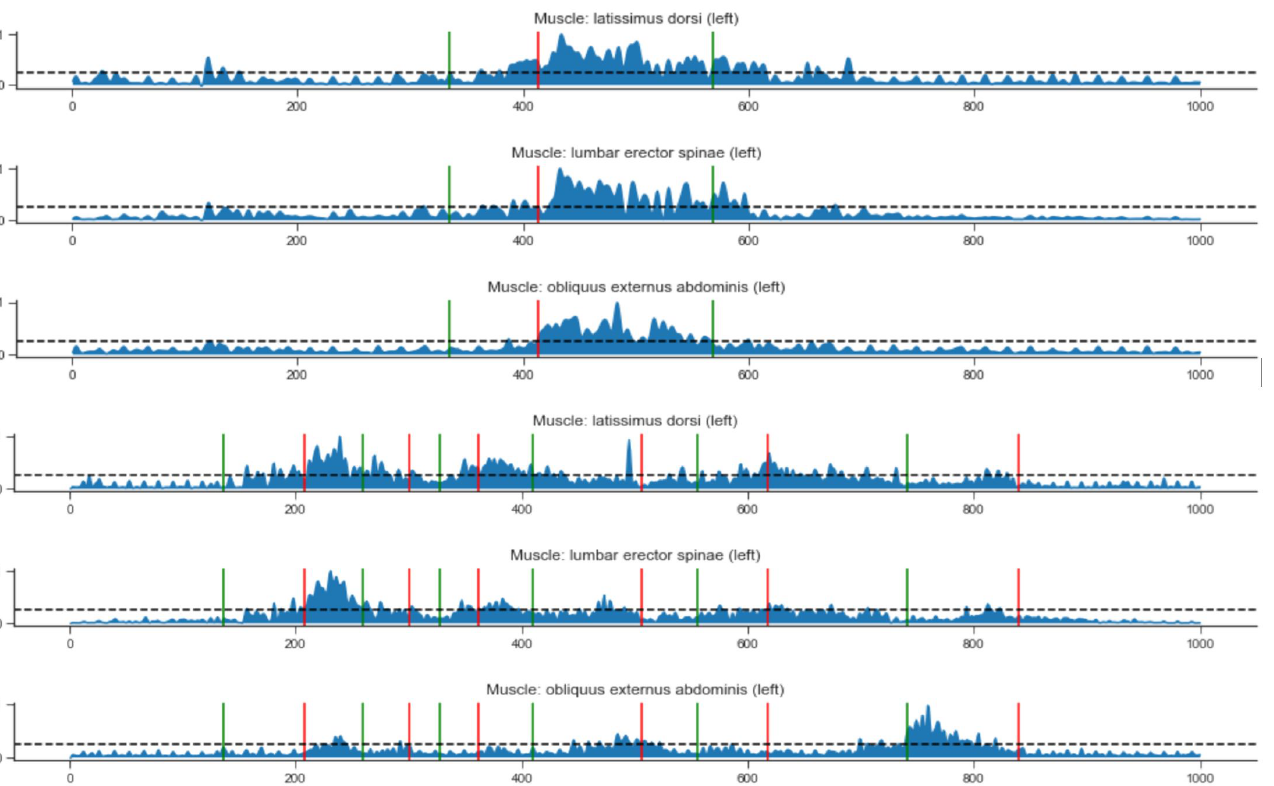
Figure 5. Activities of selected muscles for the patient transfer divided into movement phases (see Table 4). The first three diagrams show the incorrect transfer, and the next three show the correct